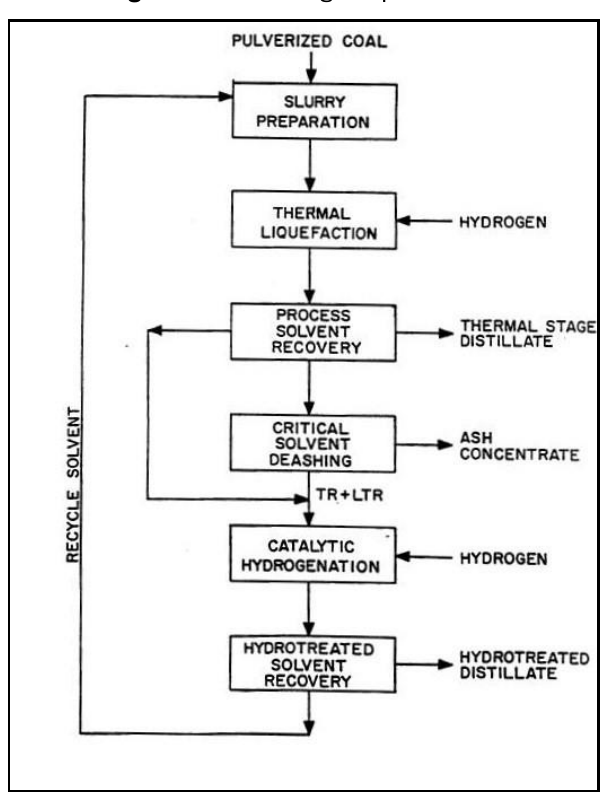
Figure 7. Two stage liquefaction.